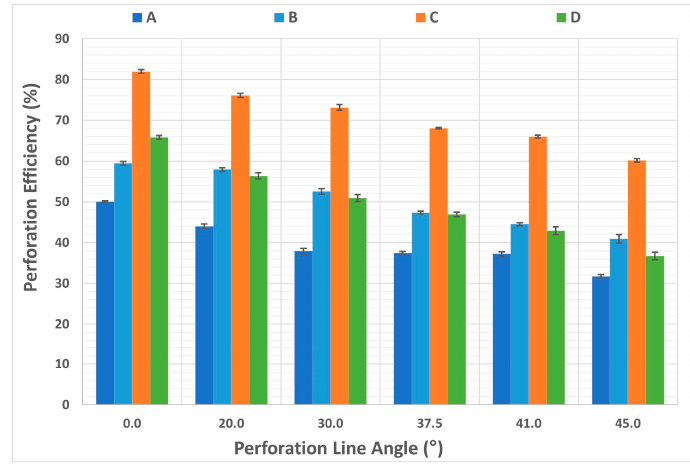
Figure 5 . Perforation efficiency behavior as function of perforation line angle .